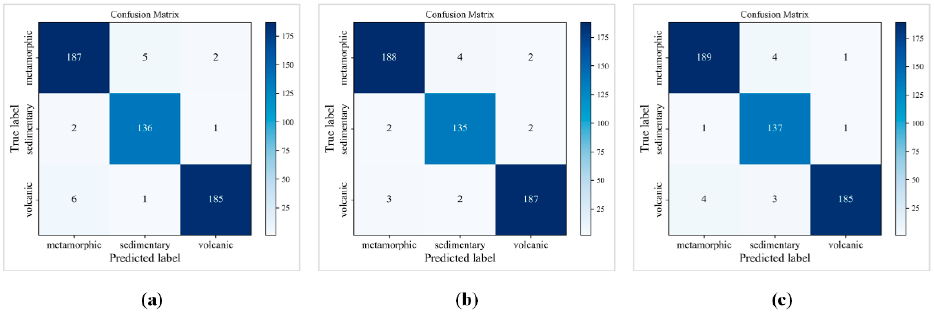
Figure 14. Confusion matrixes: ( a ) RMSprop optimizer; ( b ) SGD optimizer; ( c ) Adam